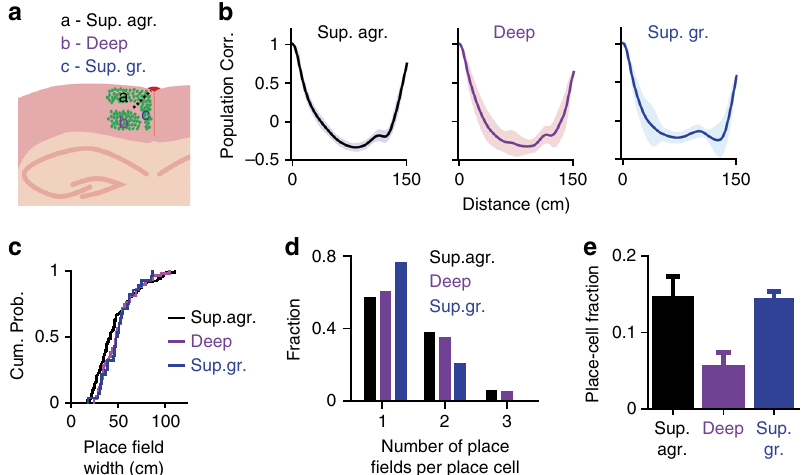
Fig. 4 RSC place cells are more prevalent in super fi cial layers. a Diagram of three RSC sub-regions. Sup. agr.: super fi cial agranular; Deep: deep agranular and granular; Sup. gr.: super fi cial granular. Green dots represent GCaMP6m labelled neurons. Imaging at different depths revealed neurons in different sub- regions. b Mean population vector correlation as a function of distance for the three sub-regions. Shaded areas represent s.d. c Cumulative probability distributions of place- fi eld widths for super fi cial agranular ( black , n = 123), deep ( purple , n = 60), and super fi cial granular ( blue , n = 30) RSC place cells. d Distribution of place fi eld count per cell for super fi cial agranular ( black bars ), deep ( purple bars ) and super fi cial granular ( blue bars ) RSC place cells. e Place cell fraction in super fi cial agranular ( black bar ), deep ( purple bar ), and super fi cial granular ( blue bar ) RSC. Error bars: s.e.m. (Data from WT mice with AAV1-hSyn-GCaMP6m (Fig. 3d and Supplementary Fig. 1i) and during free movement on real linear tracks 35 .